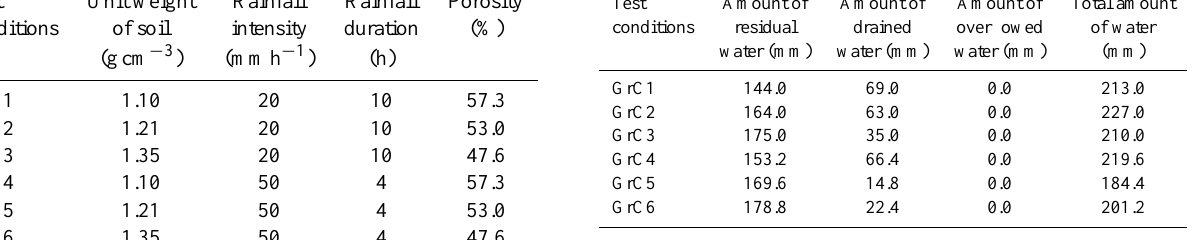
Table 3. Amount of the injected water into the soil column. Test Amount of Amount of Amount of Total amount conditions residual